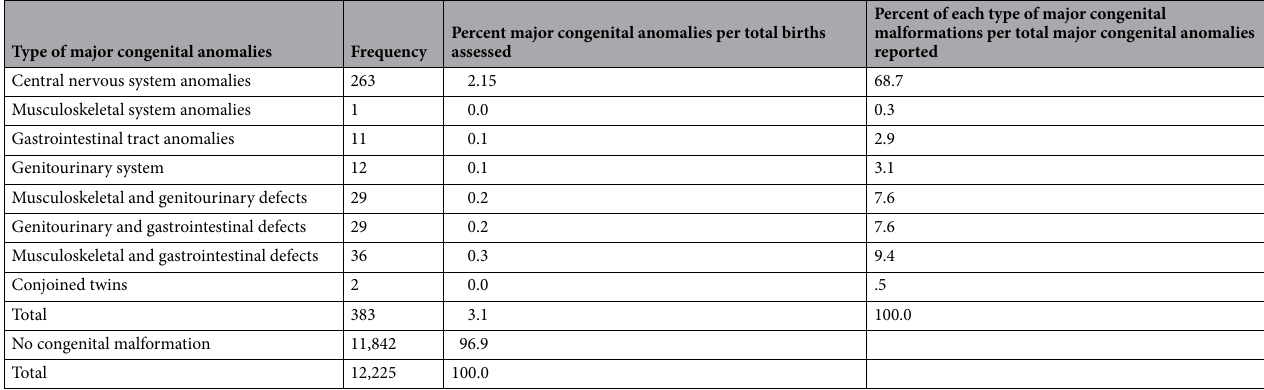
Table 2. Type and prevalence of the major congenital anomalies in Tigray, Northern Ethiopia, 2019. Column 3, the percentage of neonate with congenital anomalies (CAs) was calculated as total number of CAs per total birth assessed (total CAs cases identified/total birth observed) and in column 4 the percentage of each type of CAs was calculated as identified type of CAs per total CAs observed (type of CAs identified /total